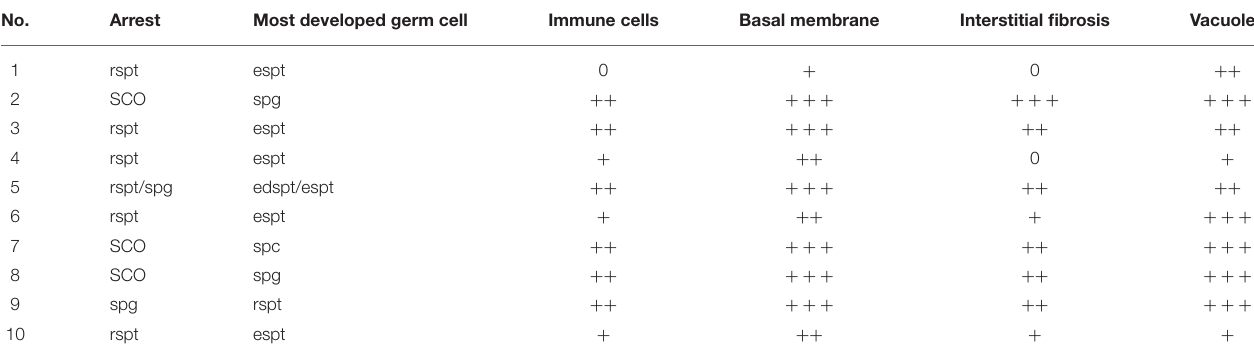
TABLE 2 | Histological characterization of testicular biopsies obtained from azoospermic dogs. Table describes arrest of spermatogenesis in more detail by giving details on 1. which level majority of tubules are arrested on (arrest) and 2. most developed germ cell found. Besides presence of immune cells (immune cells: 0- ++ ), thickening of basal membrane (basal membrane: 0- + + + ), interstitial fibrosis (fibrosis: 0- + + + ), and presence of intratubular vacuoles (vacuoles: 0- + + + ) are scored semiquantitatively. No. Arrest Immune cells Basal membrane Interstitial fibrosis